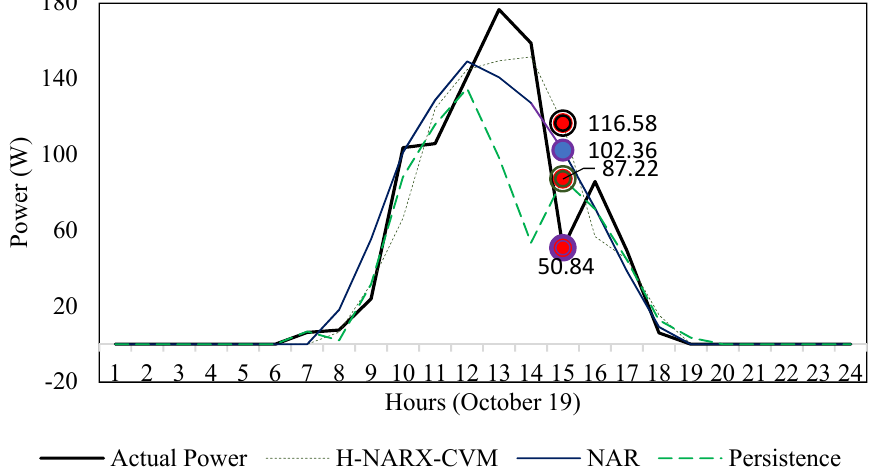
Figure 14. Actual active power model versus the proposed methodology, NAR and persistence models.